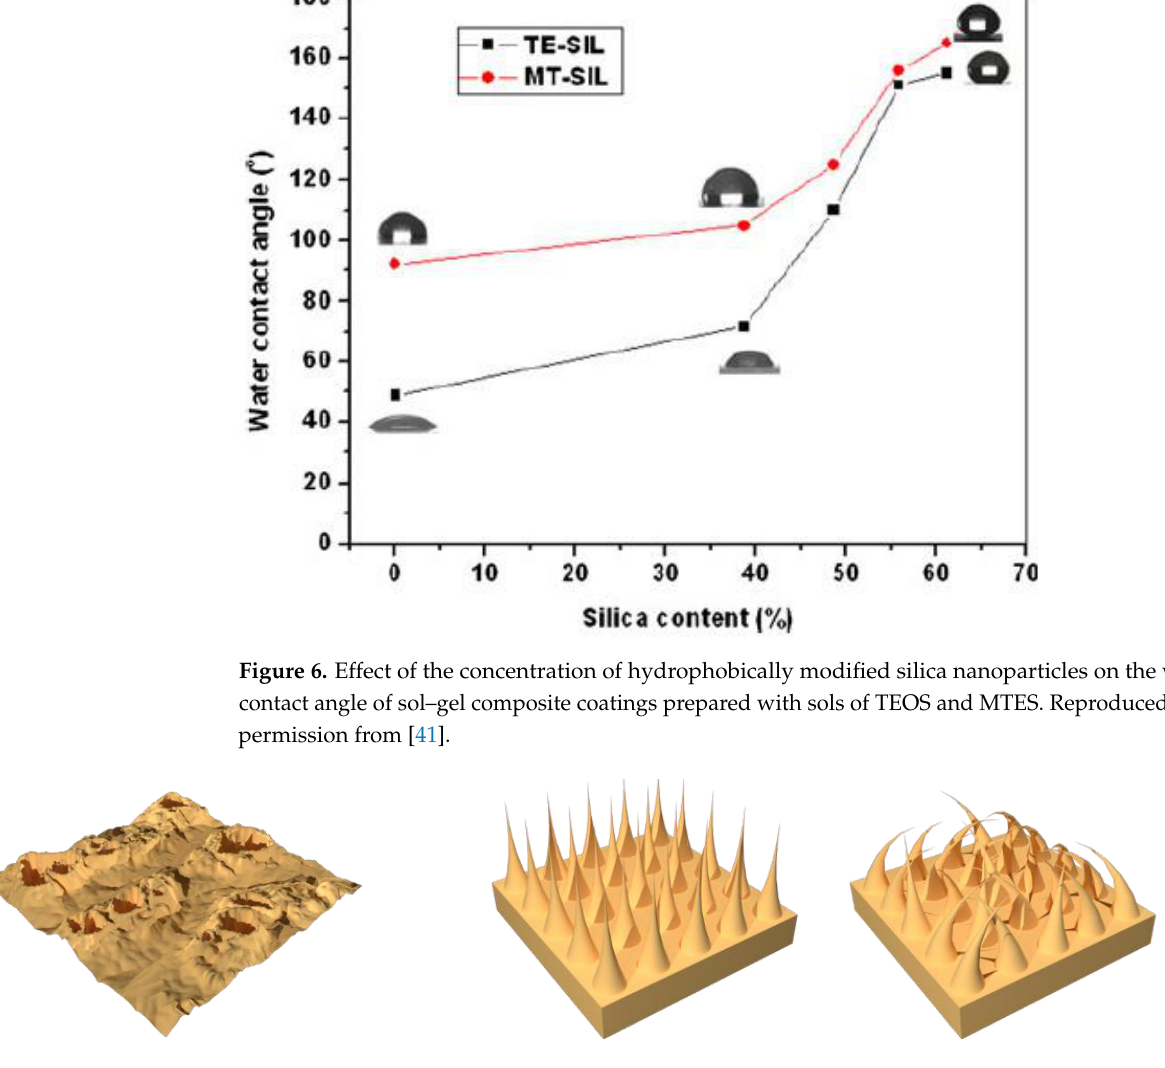
Figure 7. Representation of ( a ) crater-like morphology, ( b ) needle-like morphology.